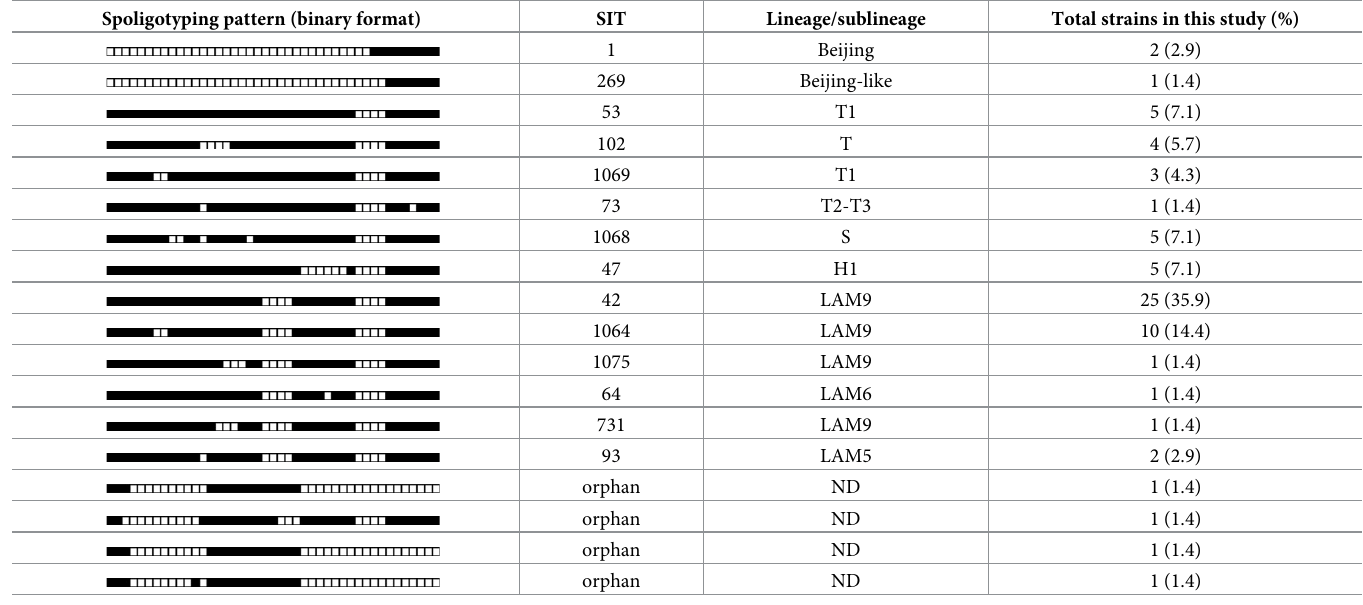
Table 1. Description of types generated by spoligotyping in this study by SIT and clade. Spoligotyping pattern (binary